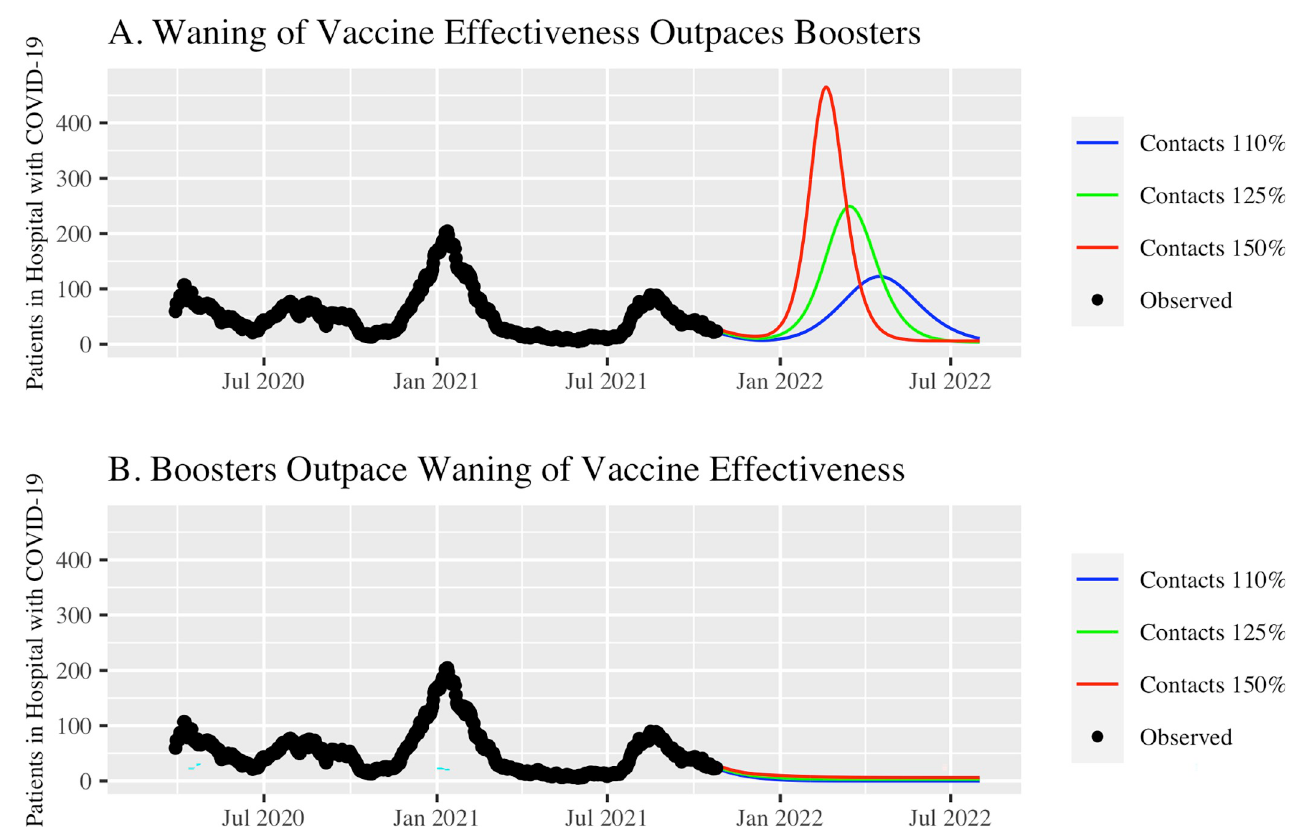
Fig 1. Observed COVID-19 hospital census in San Francisco through October 25, 2021 (black dots) and projected hospital census over coming months (colored lines) assuming differing levels of risk behavior change (effective contact rate increases to 110%, 125% and 150% of level on October 25, 2021) if A) waning of vaccine effectiveness outpaces booster roll-out; B) booster roll-out outpaces waning of vaccine effectiveness. Projections based on the Local Epidemic Modeling for Management and Action (LEMMA) model, calibrated to publicly available data and reflecting the epidemic pre-Omicron. Detailed description, source code, and outputs available at https://localepi.github.io/LEMMA/.